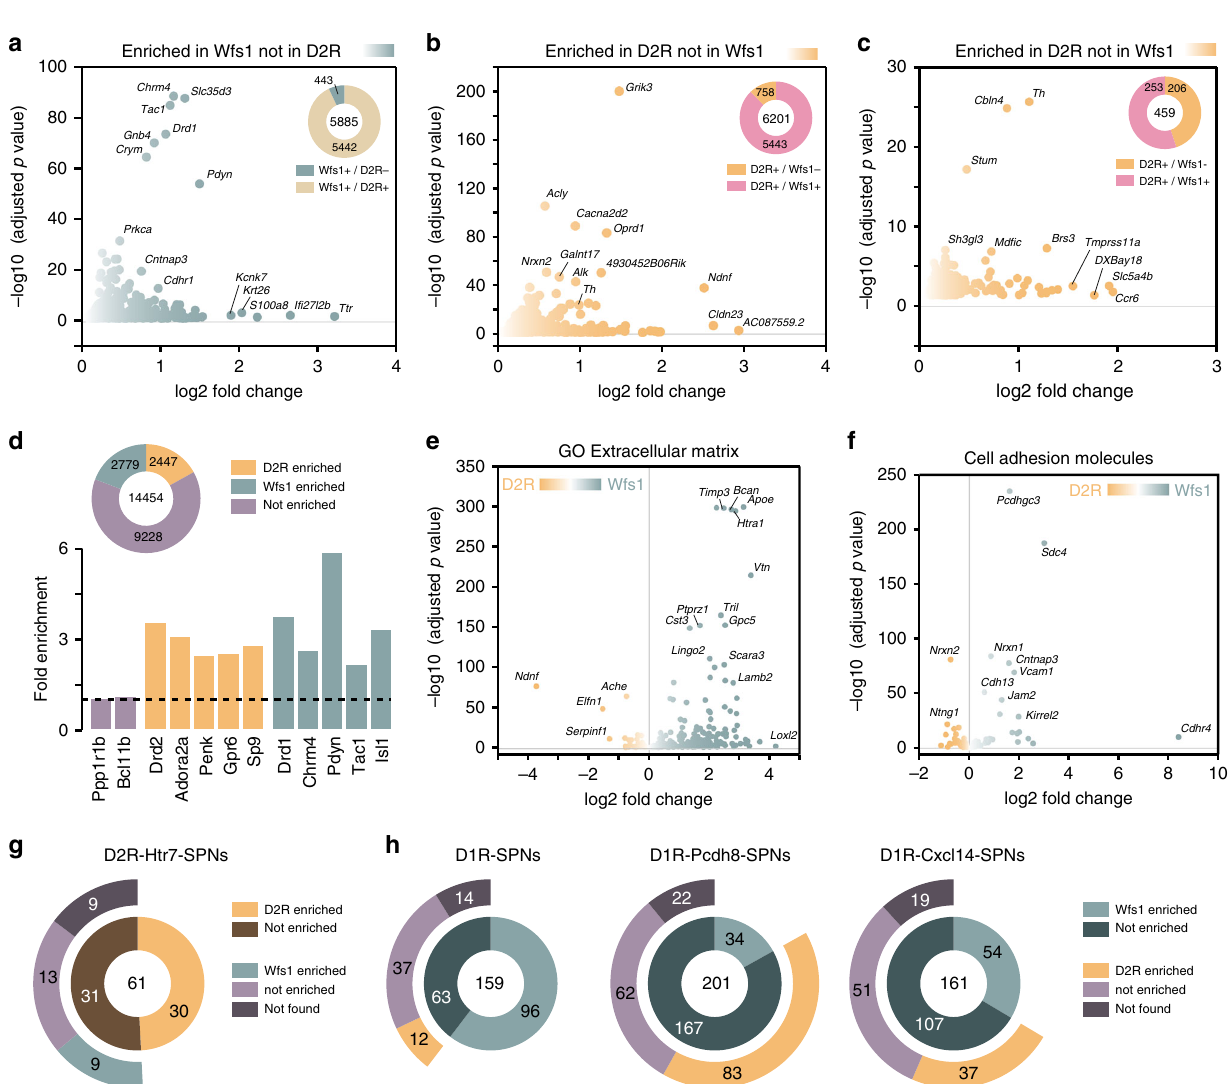
Fig. 4 Anatomical characterization of Acb WFS1 neurons. a Single-molecular fl uorescent in situ hybridization for Wfs1 mRNAs in the striatum. b Coronal section with Wfs1 immunostaining ( n = 3 mice/group). c Coronal section with HA immunostaining from Wfs1-RiboTag mice ( n = 4 mice/group). d Validation by RNAseq of the de-enrichment of markers for astrocytes, microglia, oligodendrocytes, and vascular cells, and the enrichment of GABAergic cells markers after HA-immunoprecipitation on Acb extracts compared with the input fraction (containing the mRNAs from all cellular types). e Fold- change of protein-coding genes enriched in the Acb pellet fraction of Wfs1-RiboTag mice. f Volcano plot depicting protein-coding genes enriched in the Acb of Wfs1 neurons. g Fold-change of SPNs, dSPNs, and iSPNs markers from the Acb pellet fraction of Wfs1-RiboTag mice. h Double IF for GFP and Wfs1 in D2- and D1-eGFP mice ( n = 3 mice/group). i Quanti fi cation of GFP/Wfs1 cells in the Acb of D2- and D1-eGFP mice. j Single-molecular fl uorescent in situ hybridization for Wfs1 (orange) and Drd2 (cyan) mRNAs in the striatum. k Fold-change of CINs markers de-enriched in the Acb pellet fraction of Wfs1- RiboTag mice. l Double IF of ChAT (orange) and HA (cyan) in the Acb of Wfs1-RiboTag mice. m Fold-change of striatal interneuron markers de-enriched in the pellet fraction of Wfs1-RiboTag mice. n Schematic of Cre-dependent AAV-mCherry Acb injection in Wfs1-CreERT2 mice and visualization of the mCherry expression (gold color) at the injection site as well as ( o ) in output structures identi fi ed by co-staining with ENK (ventral pallidum, VB) and TH (substantia nigra pars compacta, SNc, and ventral tegmental area, VTA). DS dorsal striatum, Cx cortex, Acb accumbens, AcbC accumbens core, AcbSh accumbens shell, ICjM island of Calleja, Tu olfactory tubercules, aca anterior commissure, lv lateral ventricle, cc corpus callosum.